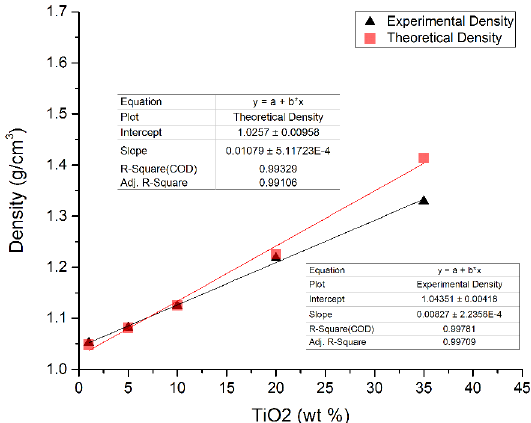
Figure 2. The experimental and the theoretical density of the TiO ABS composites